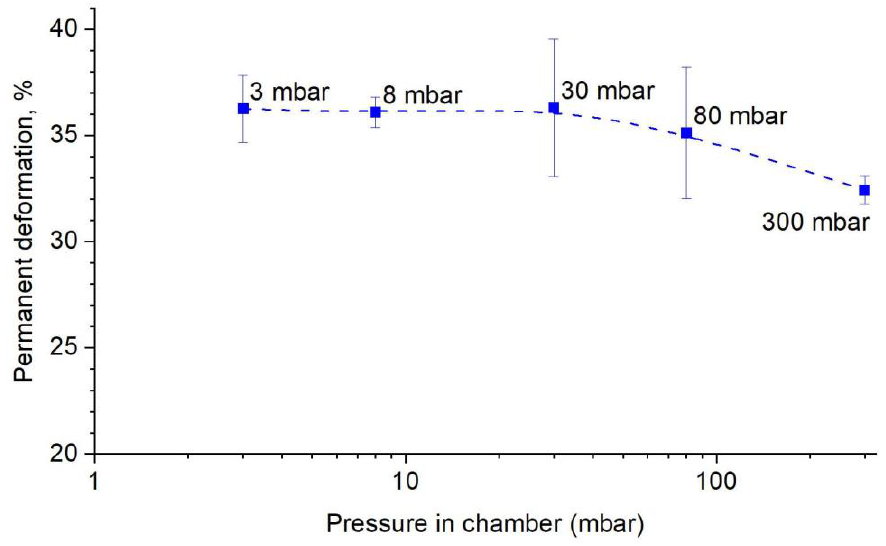
Figure 13. The change of permanent deformation as a function of pressure in the chamber.